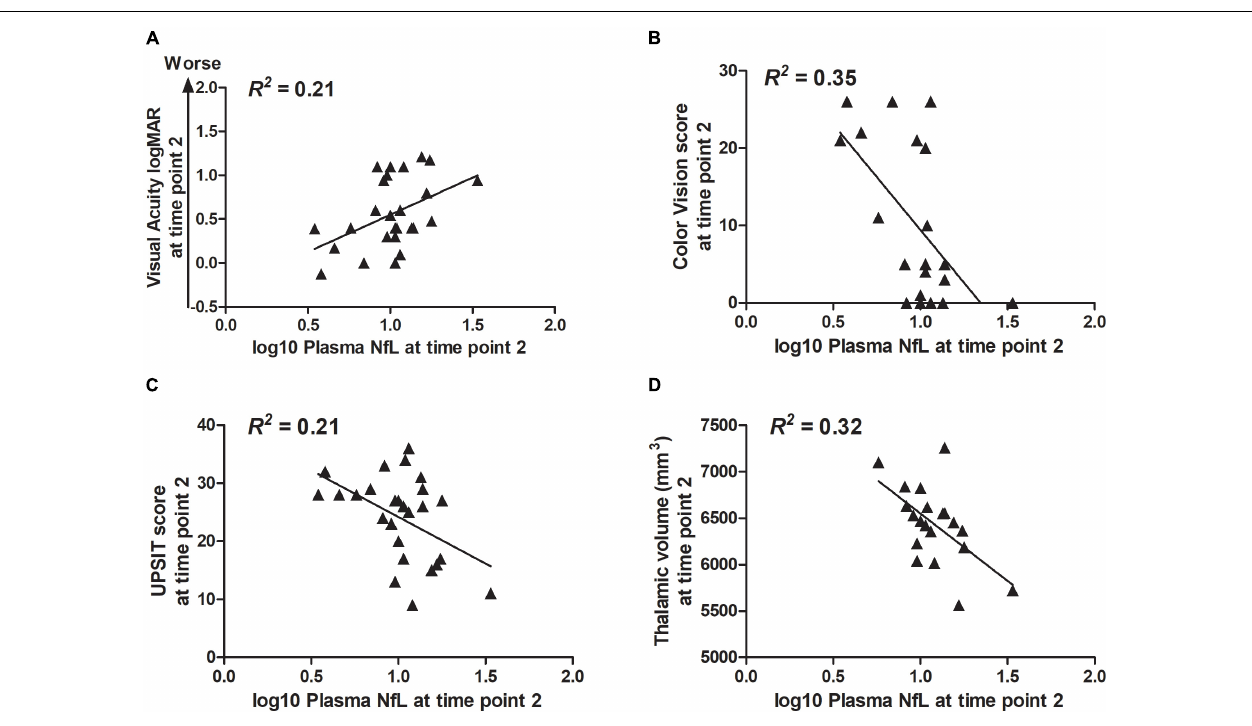
and siblings of individuals in the Wolfram group. In